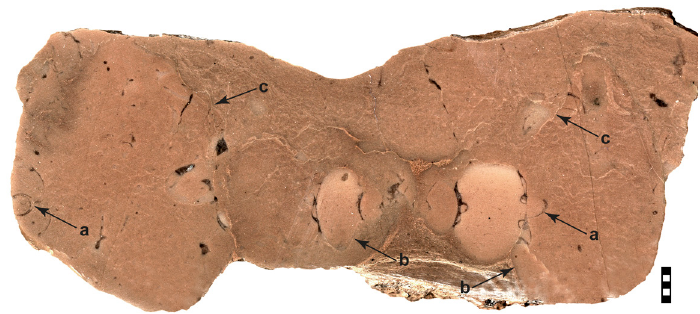
Fig. 13. Cross section of a specimen of Paratirolites sp. from Baghuk Mountain, MB.C.22215; note the different states of preservation of shell walls and septa: a = recrystallized but rather well-preserved shell wall and septa preferably in the mid-dorsal portion of the ammonoid conch; b = dissolved shell wall but sharp demarcation of the ammonoid’s internal mould from the sediment at the lower side of the ammonoid conch; c = dissolved shell wall and nearly continuous transition from the ammonoid’s internal mould towards the sediment on the upper side of the ammonoid conch (from Leda et al . 2014).